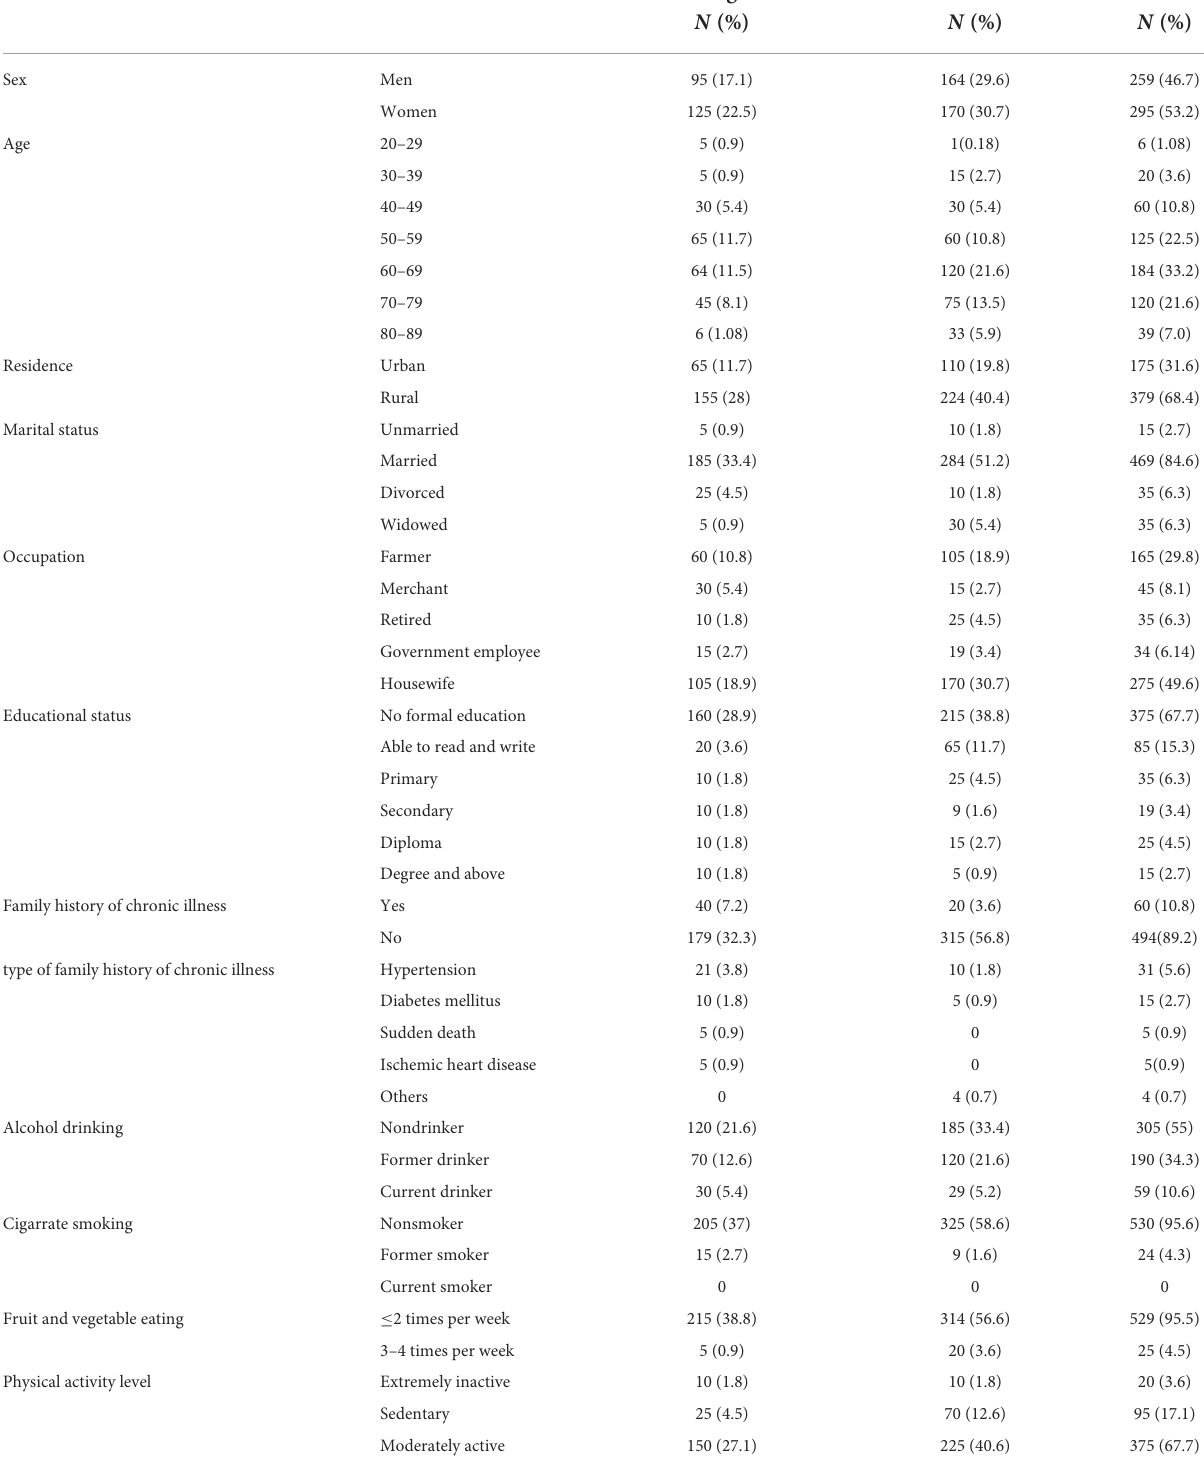
TABLE 1 Characteristics and risk profile of patients with stroke admitted to public referral hospitals, Northwest Ethiopia,